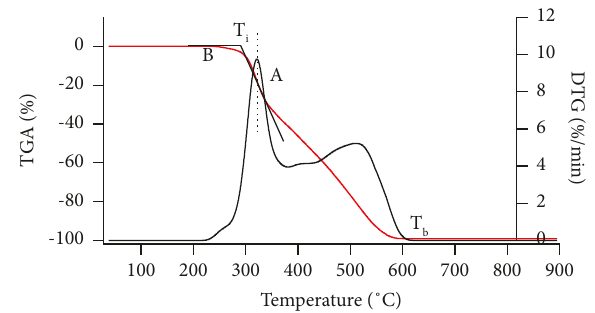
Figure 1: Schematic of determining T